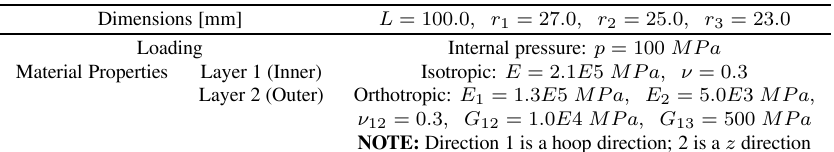
Table 2 Material properties and dimensions of the pinched cylinder